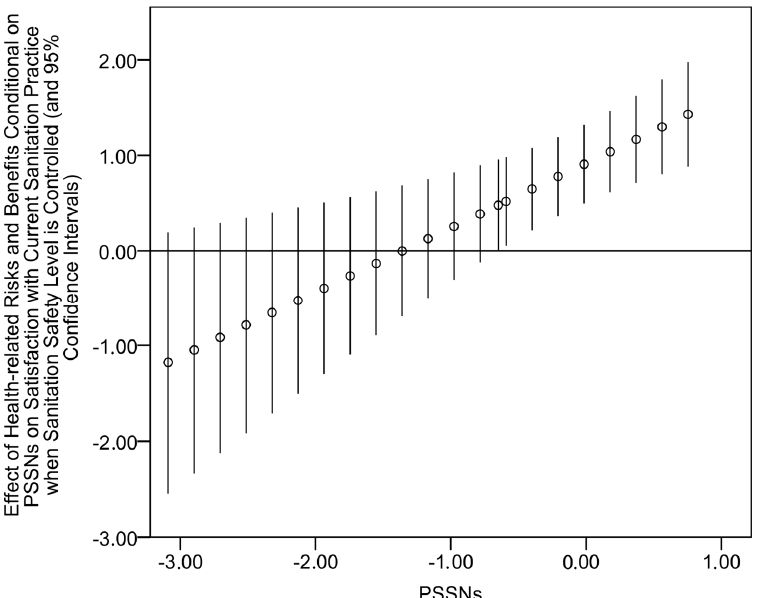
Figure 6. Effects of perceived health-related risks and benefits on satisfaction with current sanitation practice when sanitation safety is controlled conditional on different values of PSSNs (small circles) and their 95% confidence intervals.